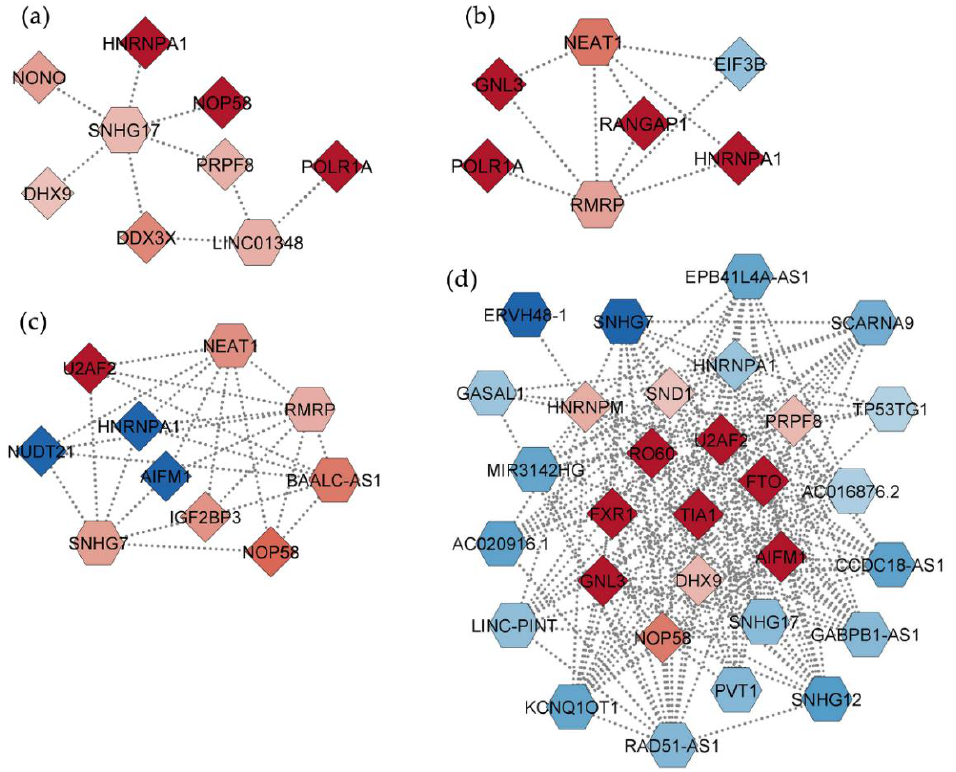
Figure 4. Interaction networks between DELs (hexagons) and DEPs (diamonds), as inferred by publicly available validated experiments, in HepG2 cells treated for 72 h with ( a ) BDE-47, ( b ) BDE-99, ( c ) BDE-209 or ( d ) MIX at 1 nM. Only nodes with BC, CC, and D > 90th percentile are shown. Shades of blue and red represent, respectively, the magnitude of down- or up-regulation.